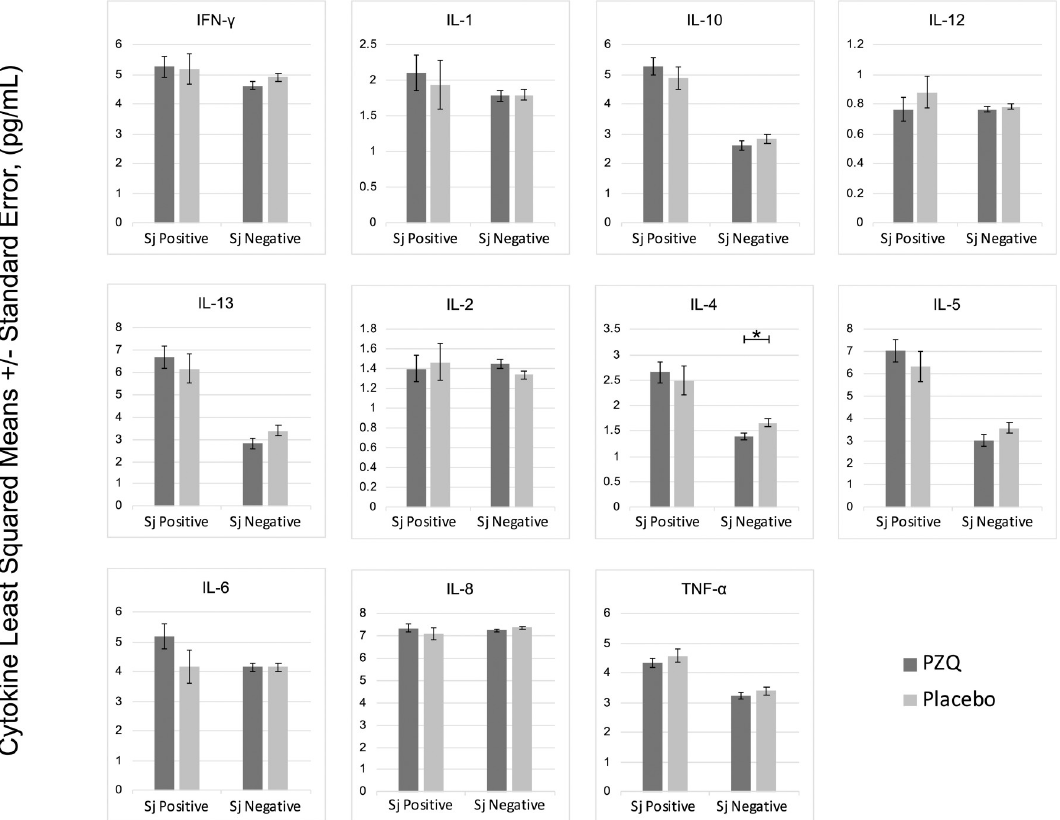
Fig 2. PZQ in utero priming: cytokines stimulated with Soluble Worm Antigen, N = 295. Values are natural log-transformed. Each model adjusted for the antigen stimulation negative control. Asterisks represent significant differences determined by multivariate